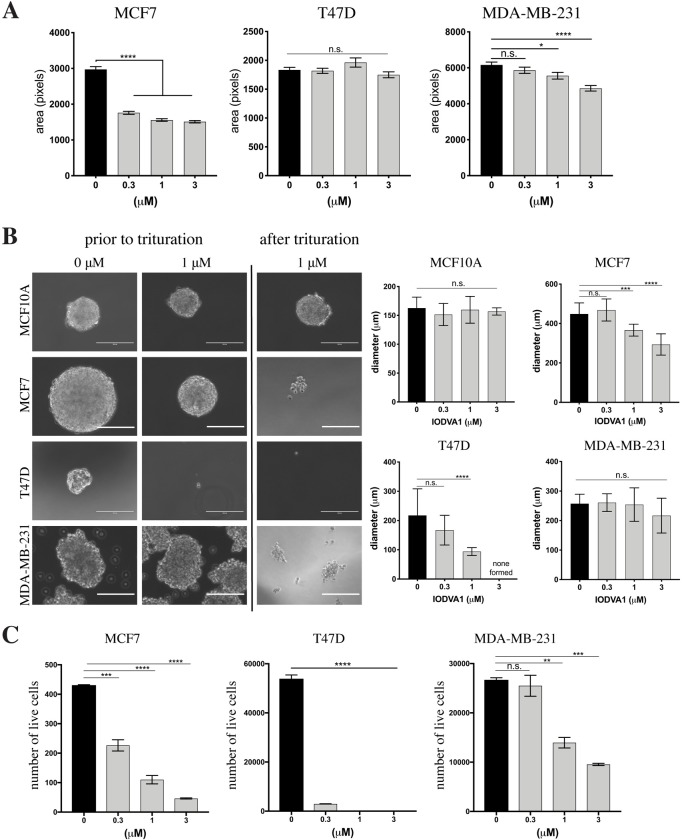
IODVA1 inhibits cell-substratum and cell-cell interactions.(A) IODVA1 impedes spreading of MCF7 and MDA-MB-231 cells on fibronectin. MCF7, T47D, and MDA-MB-231 cells were incubated on fibronectin coated coverslips for 10 min, then further incubated with the indicated concentrations of IODVA1 for 30 min in serum-free media, fixed and observed by bright field microscopy. Areas of single cells were calculated from 6 random fields (no less than 300 cells total per treatment group). Results shown are mean ± s.e.m. of a single experiment and are representative of three independent experiments. See also S4B Fig. (B) Effects of IODVA1 treatment on spheroid formation in MCF10A, MCF7, T47D, and MDA-MB-231 cells. Left panel—representative bright field images of hanging drop cultures of MCF10A, MCF7, T47D, and MDA-MB-231 cells grown in the absence (0 μM) and presence of IODVA1 (1 μM) prior to and post mechanical pipetting (trituration). Scale bar = 200 μm. Right panel, changes in spheroid/aggregate size due to IODVA1 treatment indicated by the diameter of the spheroids. Results shown are mean ± stdev, N = 15. (C) IODVA1 treatment reduces proliferation capacity in adhesion-free environment. MCF7, T47D, and MDA-MB-231 cells were grown in complete media in the presence of IODVA1 or vehicle control in ultra-low attachment plates for 5 days. Aggregates and spheroids were dissociated with accutase and trituration, and the number of live cells was determined by trypan blue exclusion. Results shown are combined mean ± stdev of two independent experiments. n.s.–not significant, *—p < 0.05, **—p < 0.01, ***—p < 0.001, ****—p < 0.0001.